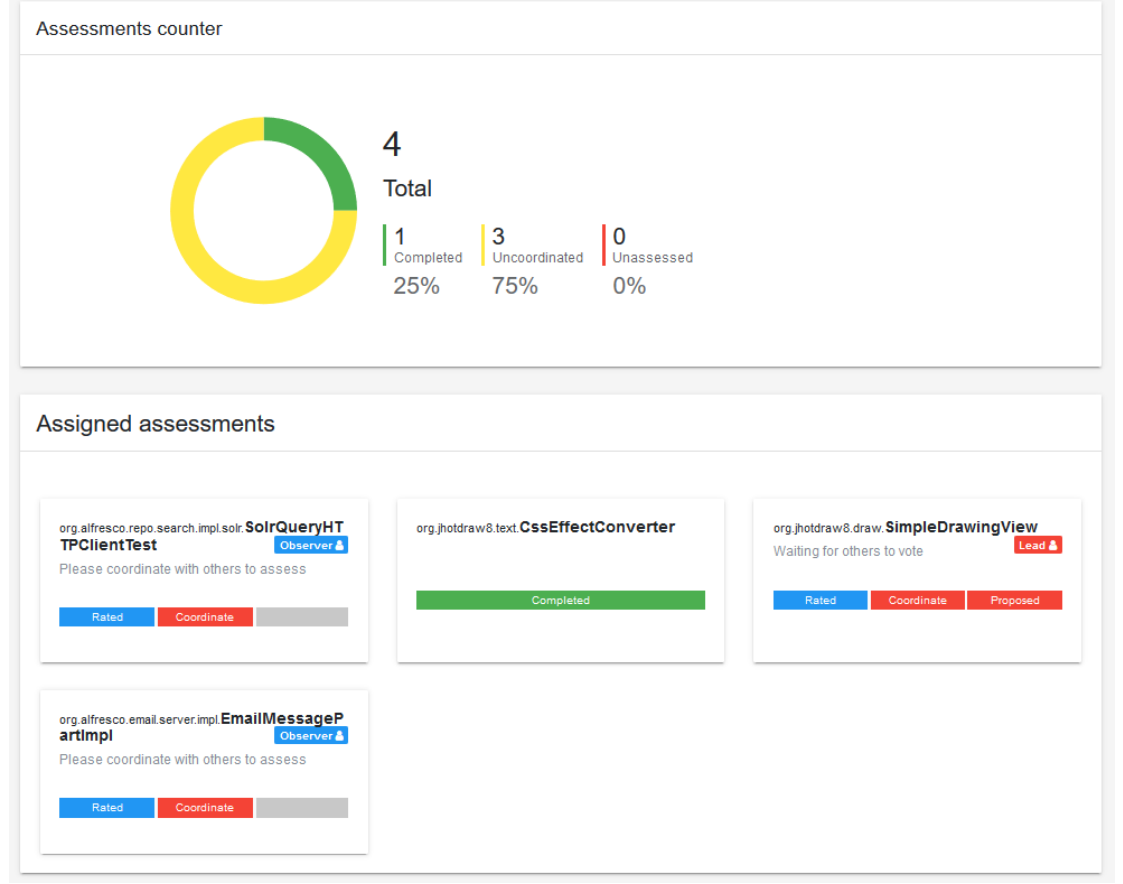
Figure 3. A screenshot from the tool, demonstrating the progress of